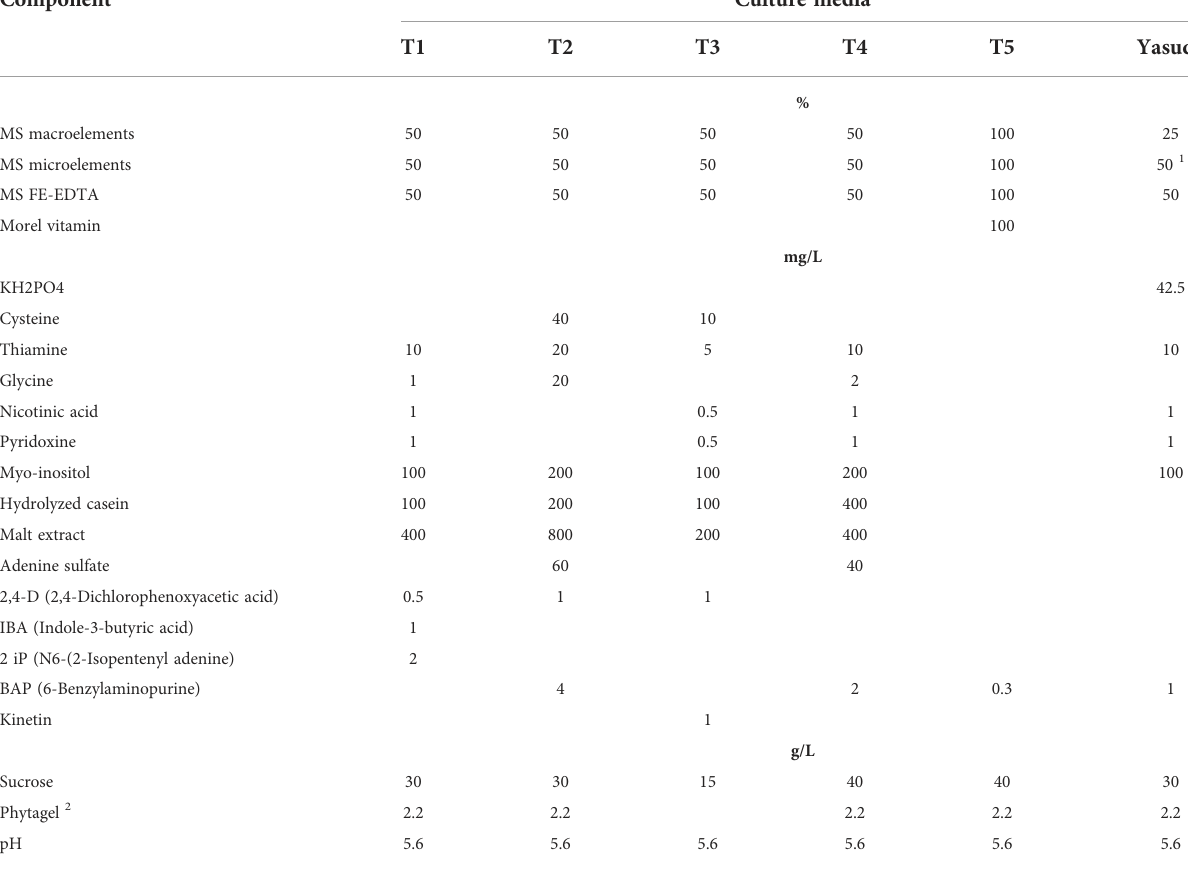
TABLE 2 Culture media components used in each phase of C. arabica somatic embryogenesis, including mineral salts, vitamins, growth regulators, organic additives and pH.